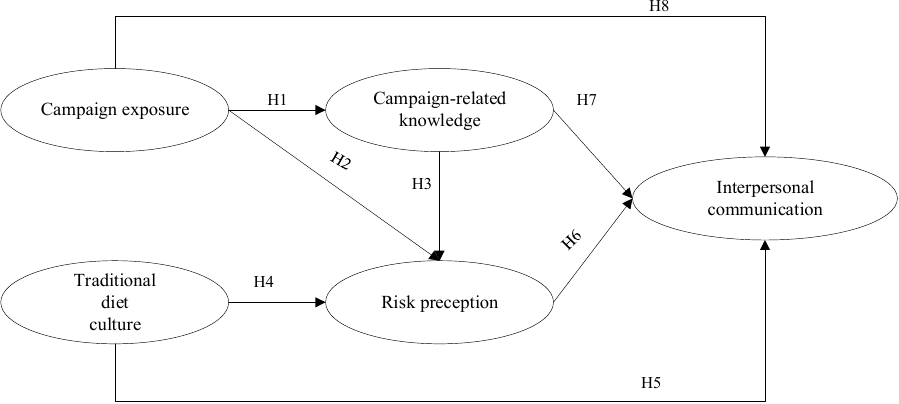
Figure 2. Research framework of interpersonal communication about Gongkuai campaign.